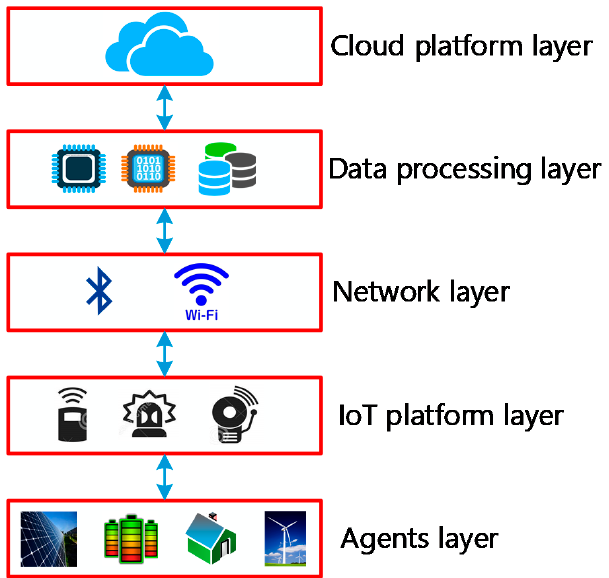
Figure 2. Proposed Internet of Energy platform